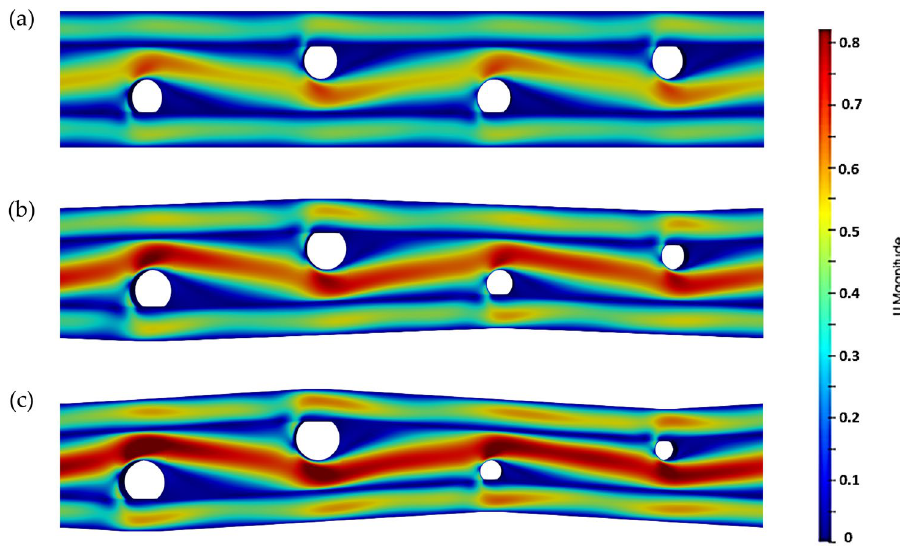
Figure 3. Velocity field with a strand diameter ratio of ( a ) R of ‘1’, ( b ) R of ‘1.5’and ( c ) R of